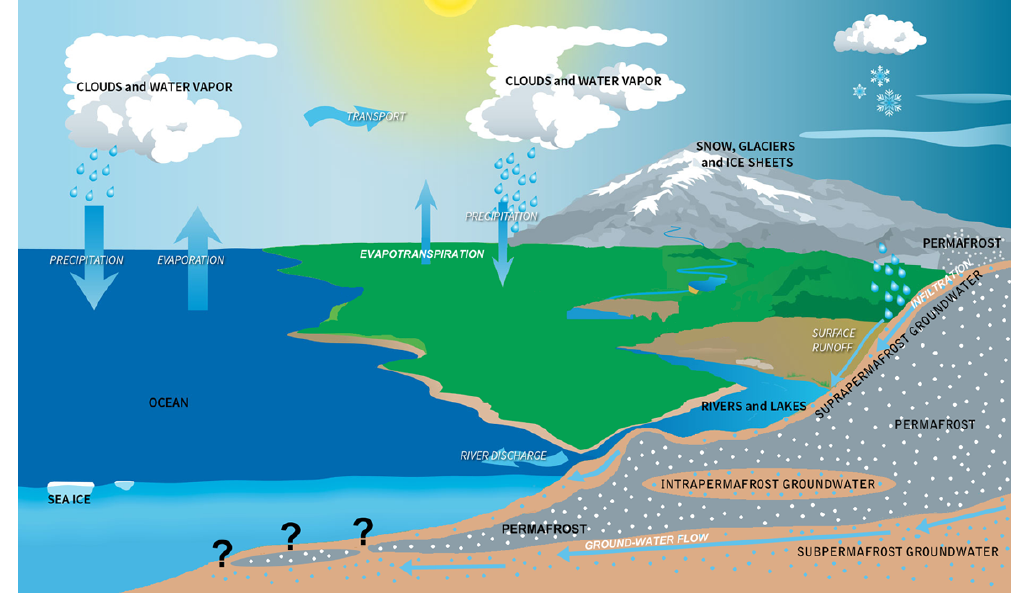
Figure 1. A view of the Arctic hydrological cycle showing key links between land, ocean, and atmosphere (modified from http://arcticchamp.